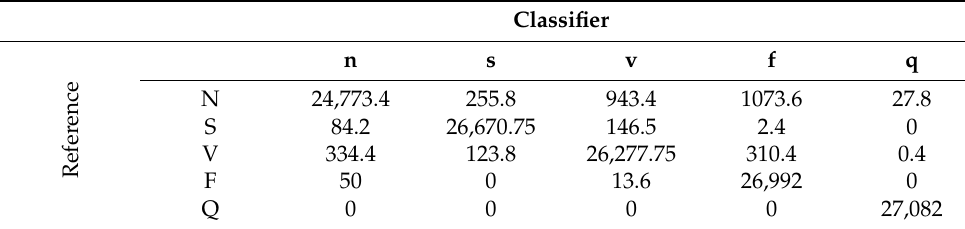
Table 16. Confusion matrix